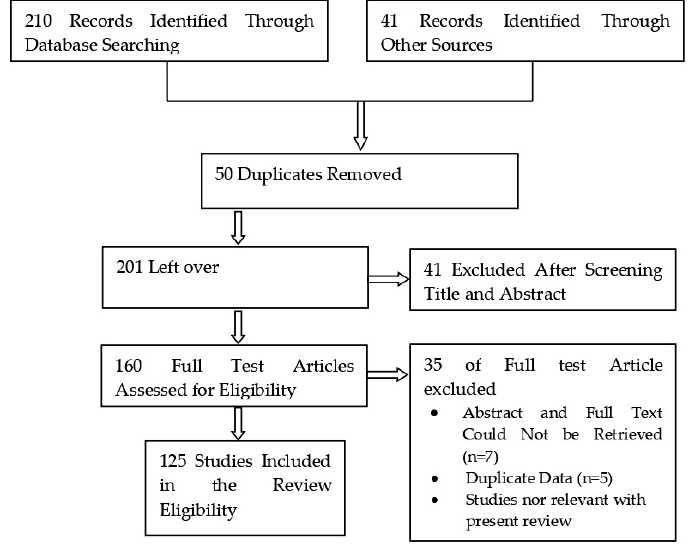
Figure 1. Flow diagram of research methodology.